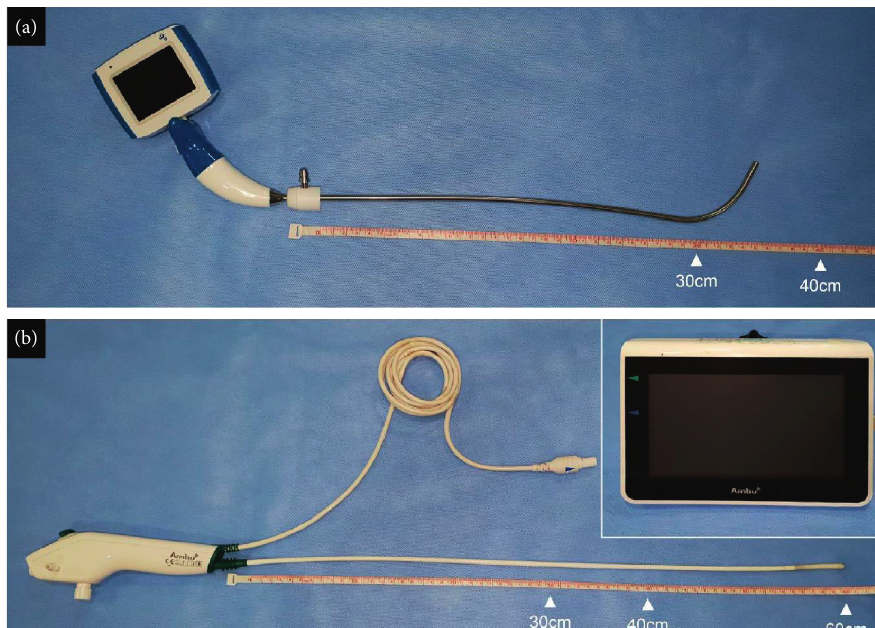
Figure 2: The appearance of the video stylet and the fiberoptic bronchoscope. The video stylet (VL400-S3 model from UE Medical Corp.) has a preformed semirigid stylet that is about 30cm, almost the same as the tube, and the monitor is attached to the body of video stylet (a). The fiberoptic bronchoscope (aScopeTM 3 Regular 5.0/2.2 model from Ambu ® ) has a long fiberscope that is about 60cm, so the tube can be placed only in the proximal part of the fiberscope, and the monitor should be placed elsewhere in the table. However, the tip of the fiberscope can be manipulated by the level in the body of the fiberoptic bronchoscope